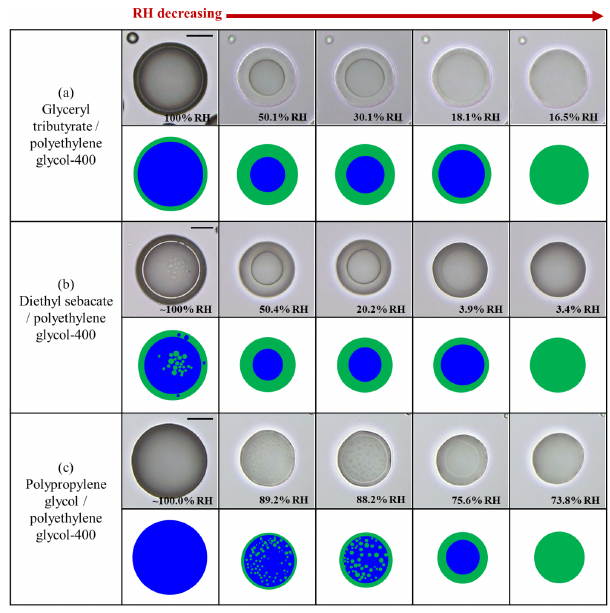
Figure 3. Optical images for particles consisting of two organic species for decreasing RH: (a) glyceryl tributyrate/polyethylene glycol-400, (b) diethyl sebacate/polyethylene glycol-400, and (c) poly(propylene glycol)/polyethylglycol-400. Illustrations are presented below the images for clarity. Green: organic-rich phase. Blue: water-rich phase. The scale bar is